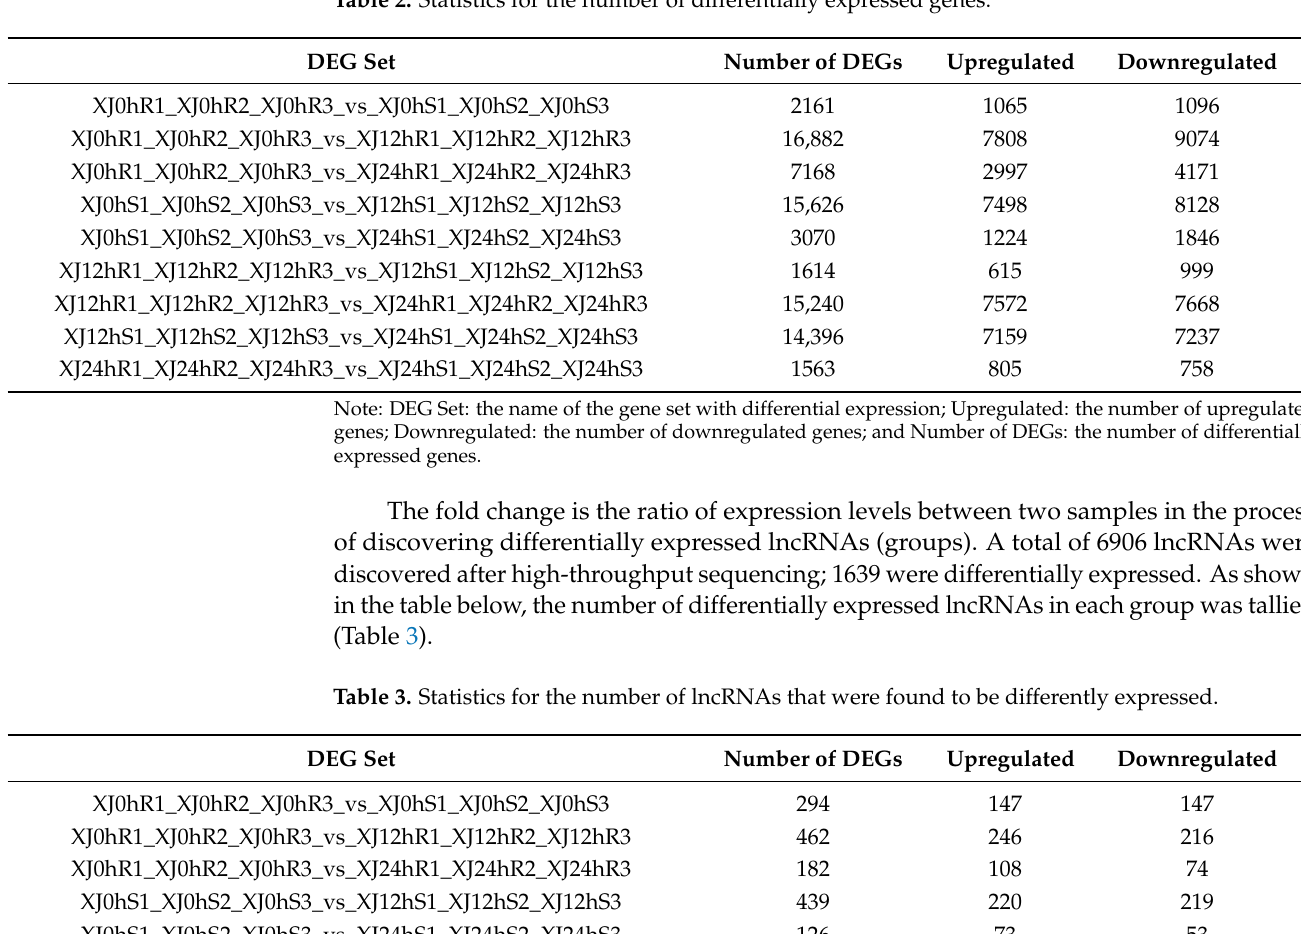
Table 2. Statistics for the number of differentially expressed genes.